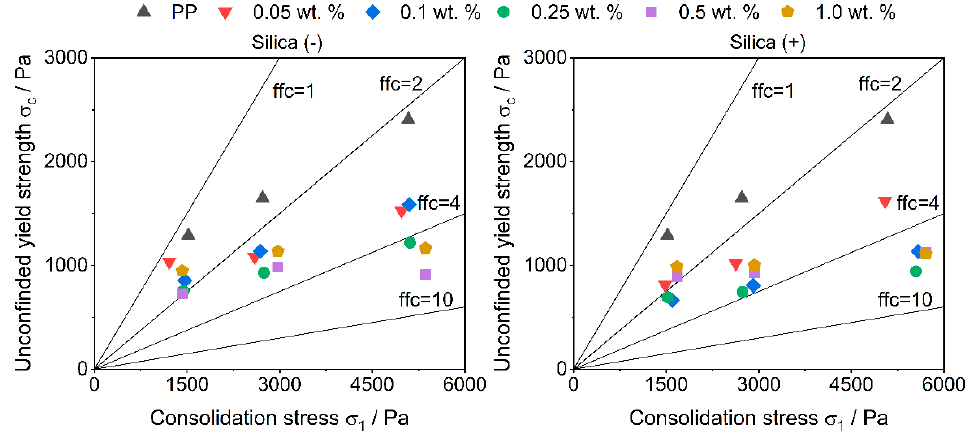
Figure 4. Flowability measured with a ring shear cell.